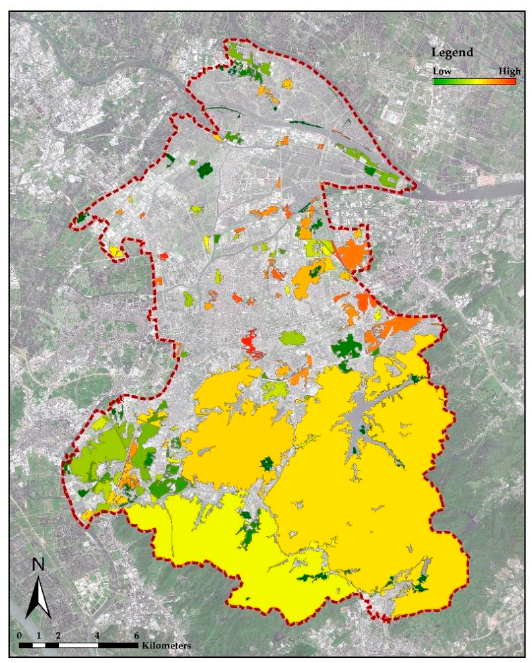
Figure 13. UGI public vitality index of the study area. Table 11. UGI area and proportion of each public vitality grade.